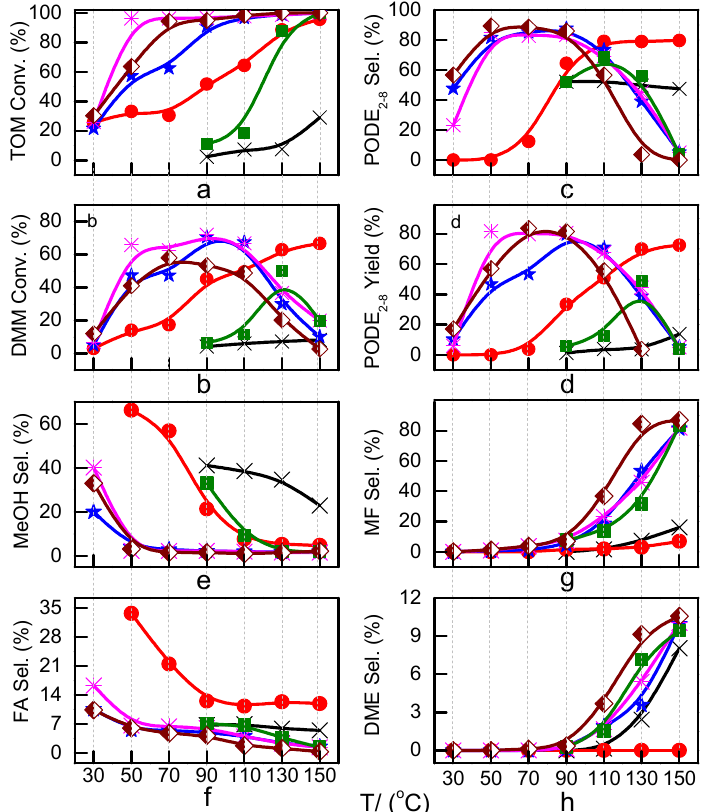
Figure 3. Reactant conversion and product selectivity over different zeolites. : USY; : Beta; : ZSM-5; (cid:4) : SUZ-4; × : SAPO-34; : MOR; ( a ): TOM conversion, ( b ): PODE 2-8 selectivity, ( c ): DMM conversion, ( d ): PODE 2-8 yield, ( e ): MeOH selectivity; ( f ): FA selectivity; ( g ): MF selectivity; ( h ): DME selectivity.